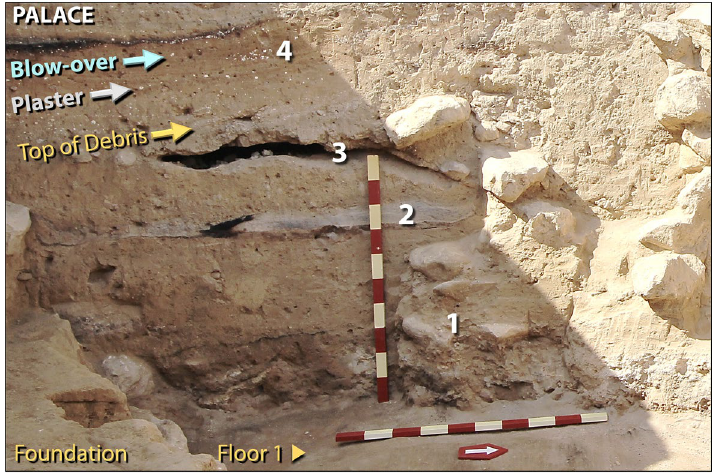
Figure 3. Destruction of the multi-storied palace. Photo showing jumbled rubble of four-story Palace atop Floor 1. Remains of debris from upper stories are labeled as follows. #1 represents broken mudbricks and debris from shattered upper walls. #2 and #3 are voids and layers formed when trapped textiles (rugs and tapestries) burned, leaving only fibrous ash and carbon. ‘Blow-over’ (in blue) is composed of windblown, laminated deposits that sealed the ruined structure for ~ 3600 years, beginning at the time of destruction. #4 marks fragments of white limestone plaster (CaCO 3 ) mixed with carbonate spherules from the palace walls and ceiling. Scale stick has 10-cm